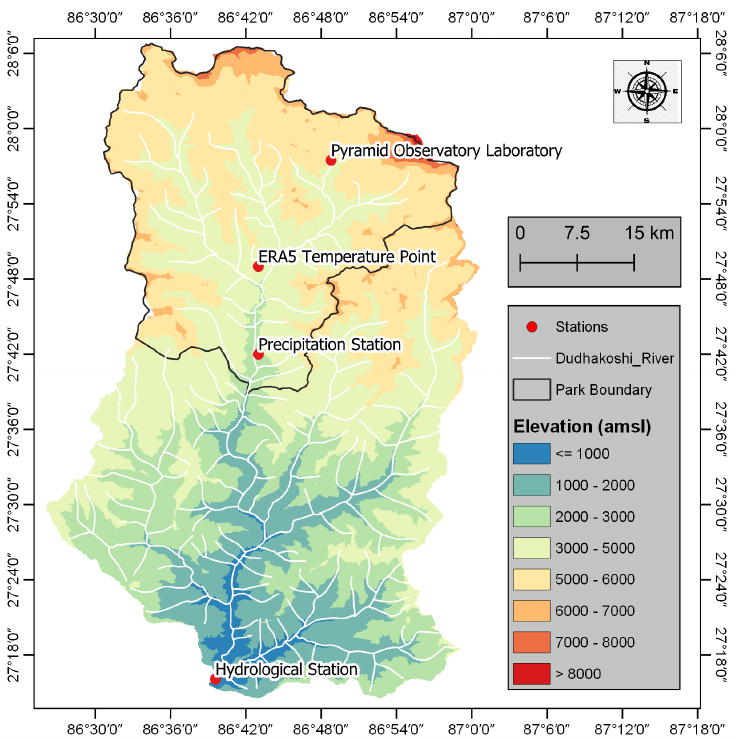
Figure 2. The elevation zone of the study area covering the Dudh Koshi watershed